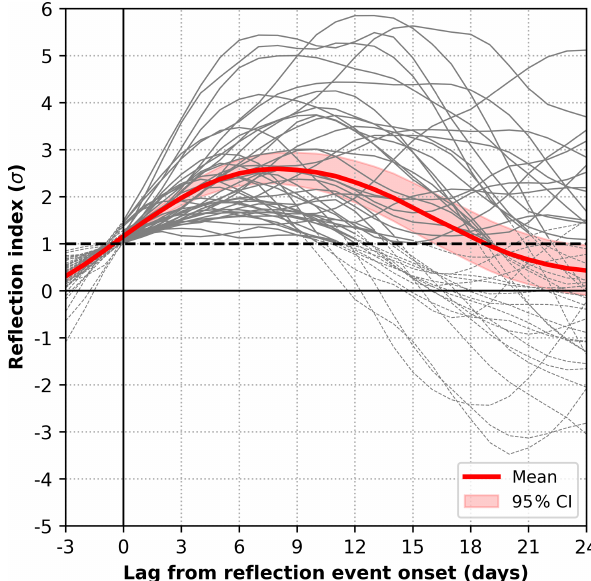
Figure 2. Vertical zonal-mean zonal wind profiles (averaged over 60–80 ◦ N) in the stratosphere. (a) Climatology of all winter days (red line), days when RI > 1 (green line) and days when RI < 1 (blue line). (b) Same as (a) but for days when RI exceeds different thresholds.